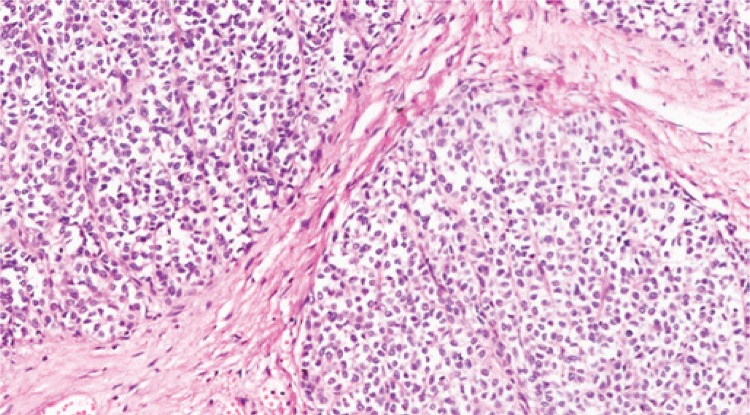
Histologia - neoplasia epitelióide com células de tamanho intermediário, nucleos irregulares, dispostas em arranjos organóides e blocos - 8 mitoses por 10 cga com focos de necrose